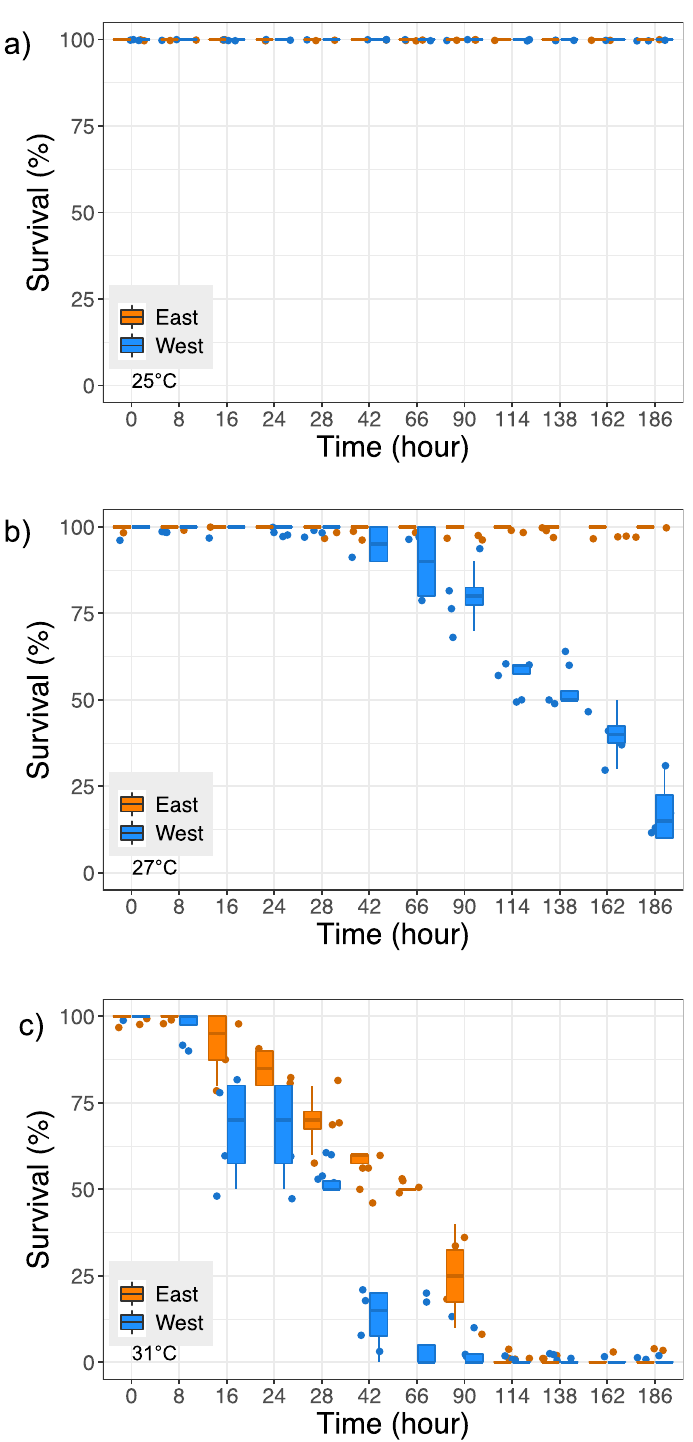
Figure 2. Survival rates in water at ( a ) 25 °C, ( b ) 27 °C, ( c ) 31 °C. Survival curves between lineages were significantly different at 27 °C and at 31 °C (long rank test; see Fig.